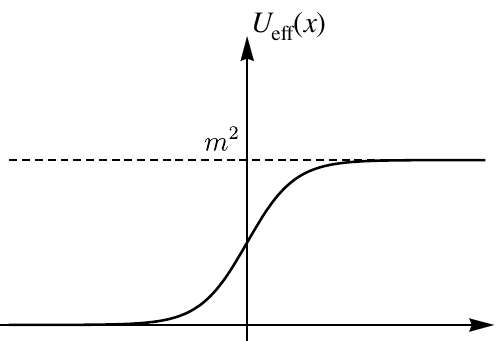
Figure 3. Potential for massive scalar linear modes in the dilaton BH background in two dimensions. The horizon is located at x → −∞